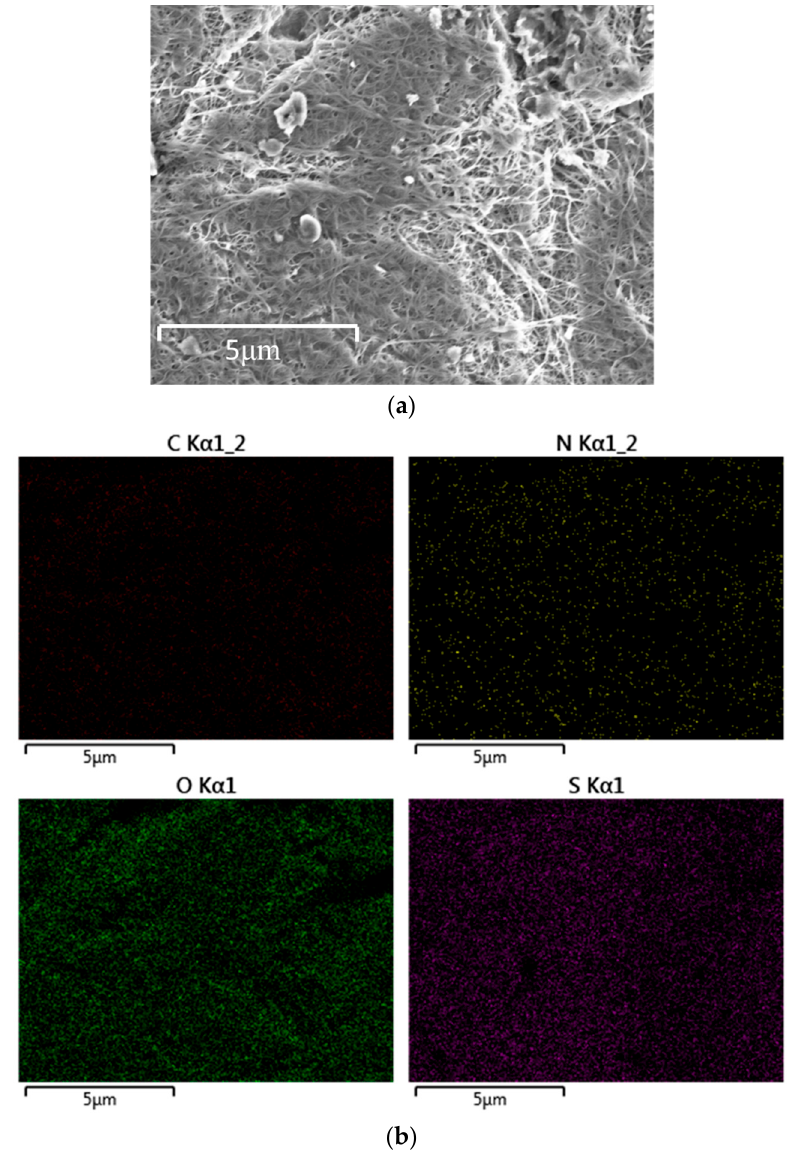
Figure 7. ( a ) SEM images of the interlayer after 100 cycles at 0.1 C; ( b ) the mapping of the cathode interlayer after 100 cycles at 0.1 C.